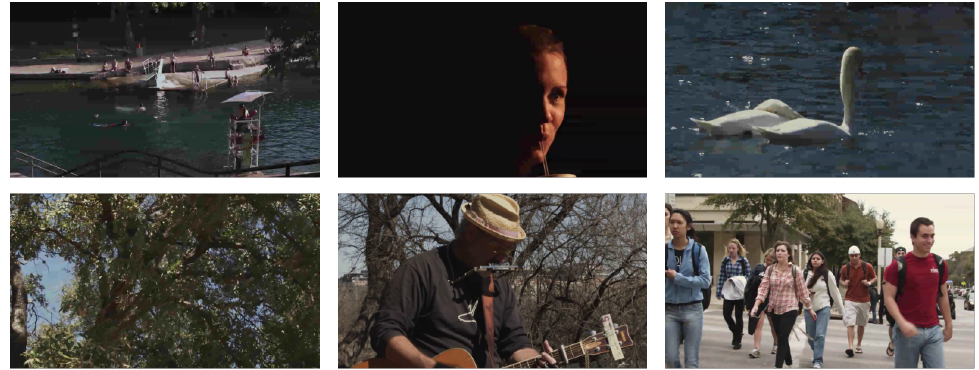
Figure 5. Snapshots from the LIVE